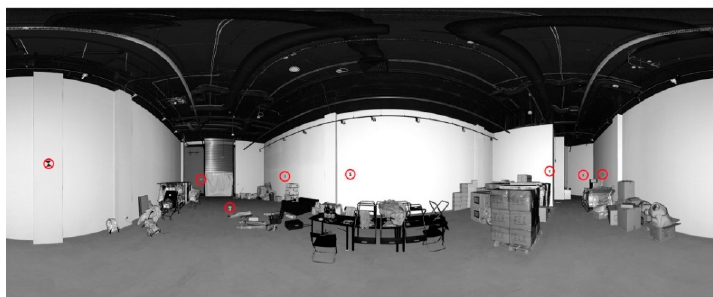
Figure 6. An example of the point cloud in the spherical projection of Test Site IV: “Empty Shop (shopping mall)” with marked check points (red circles) [27].